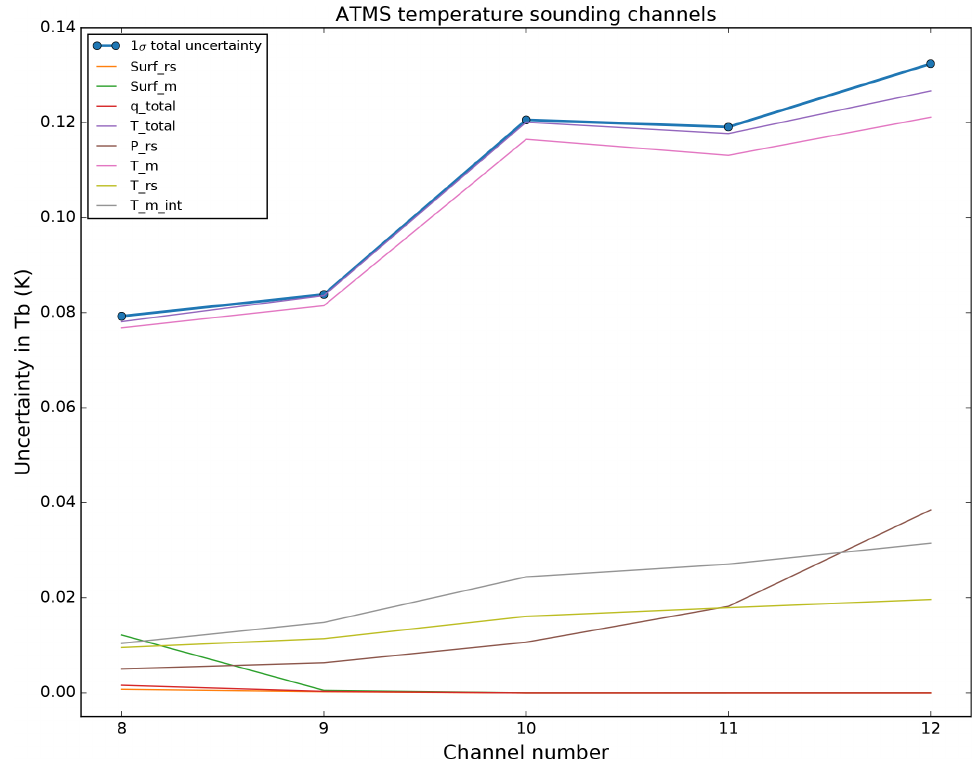
Figure 7. Same as Fig. 6 but only for ATMS temperature upper-tropospheric and lower-stratospheric channels 8–12, with the square root of the diagonal of the components forming S T_total , namely, the GRUAN temperature uncertainty (T_rs, olive), the model temperature uncertainty (T_m, pink), and the model vertical interpolation uncertainty (T_m_int,